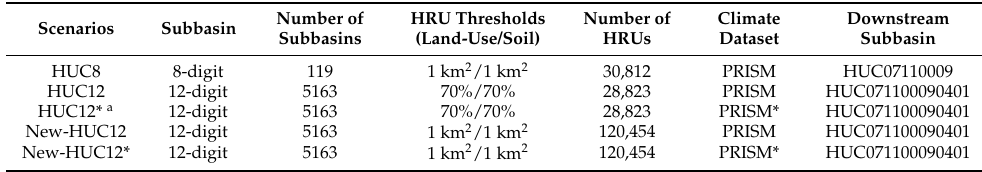
Table 2. Description of SWAT scenarios for